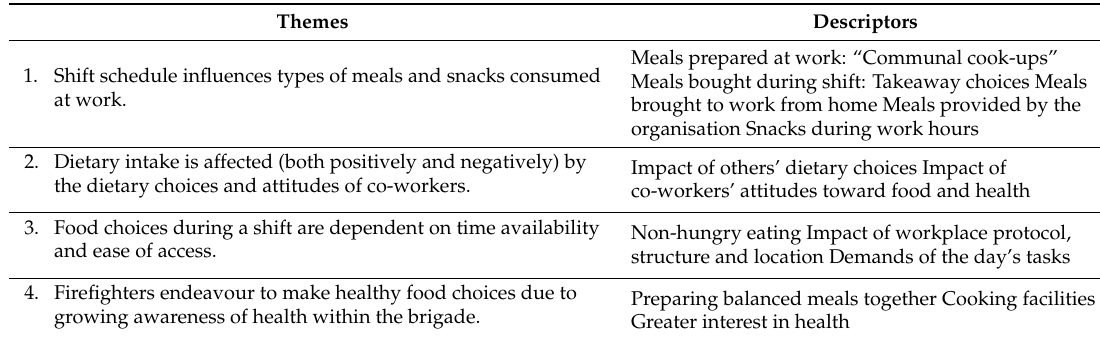
Table 3. Themes identified from focus groups of rotating shift